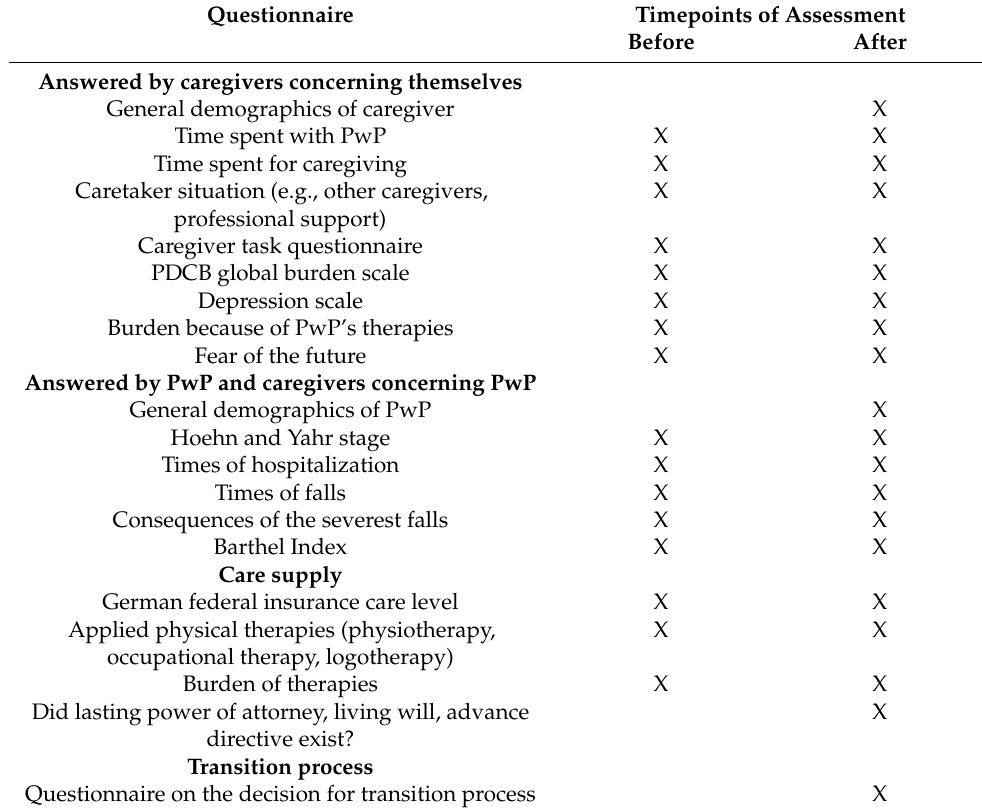
Table A1. Overview of the completed questionnaires before and after the